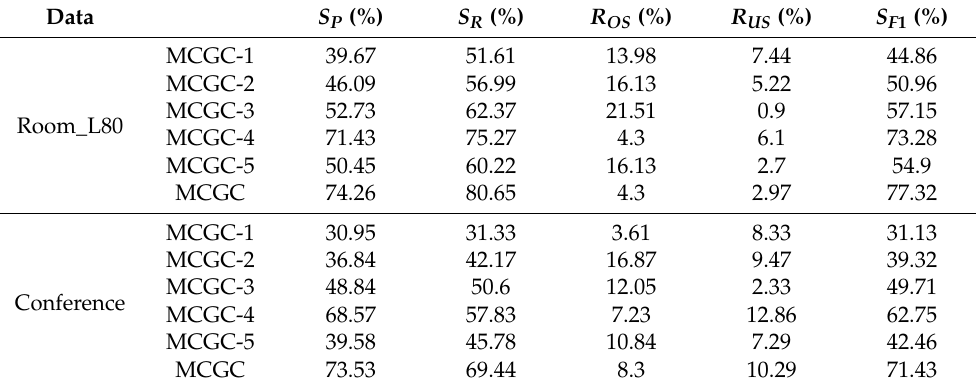
Table 5. Performance analysis of the